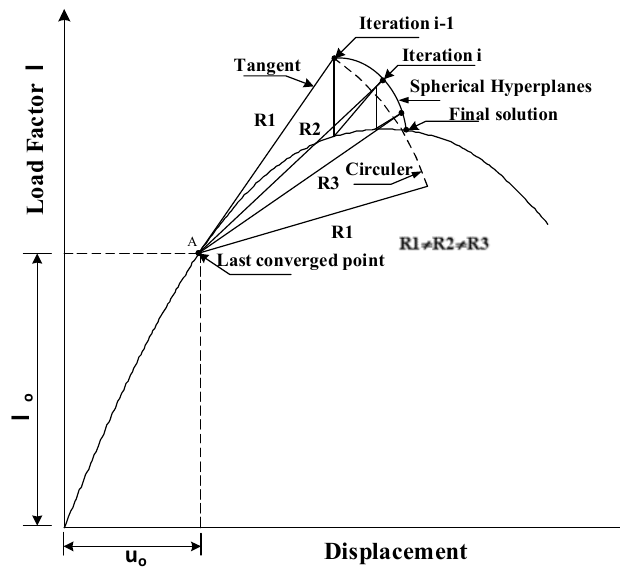
Fig. 7. Spherical hyperplanes method (Schwiezerhof and Wriggers,